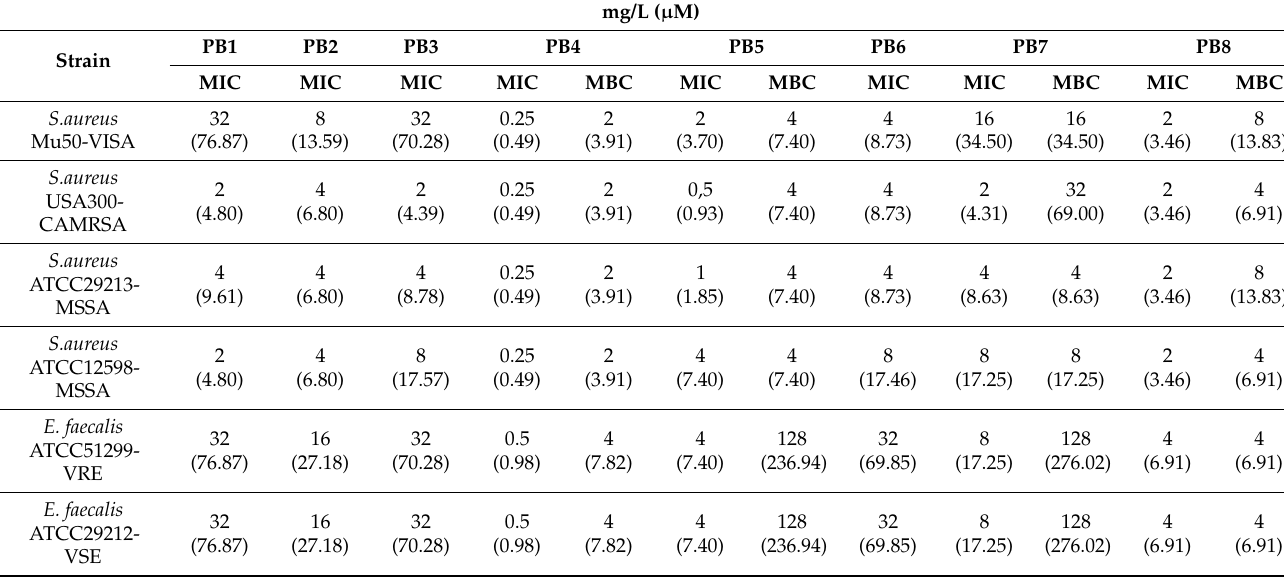
Table 1. MIC and MBC values for Gram-positive control